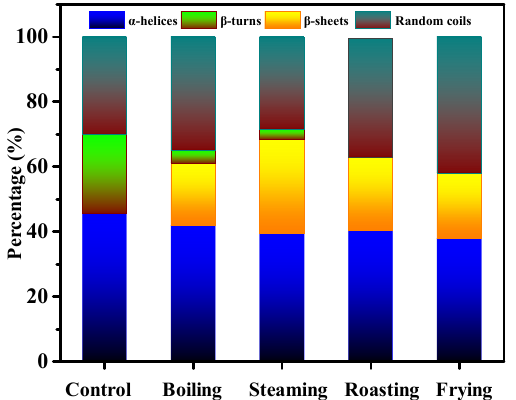
Figure 5. E ff ect of di ff erent cooking methods on the relative contents of α -helices, β -turns, β -sheets Figure 5. Effect of different cooking methods on the relative contents of α-helices, β-turns, β-sheets and random coils in MP of Spanish and random coils in MP of Spanish mackerel.